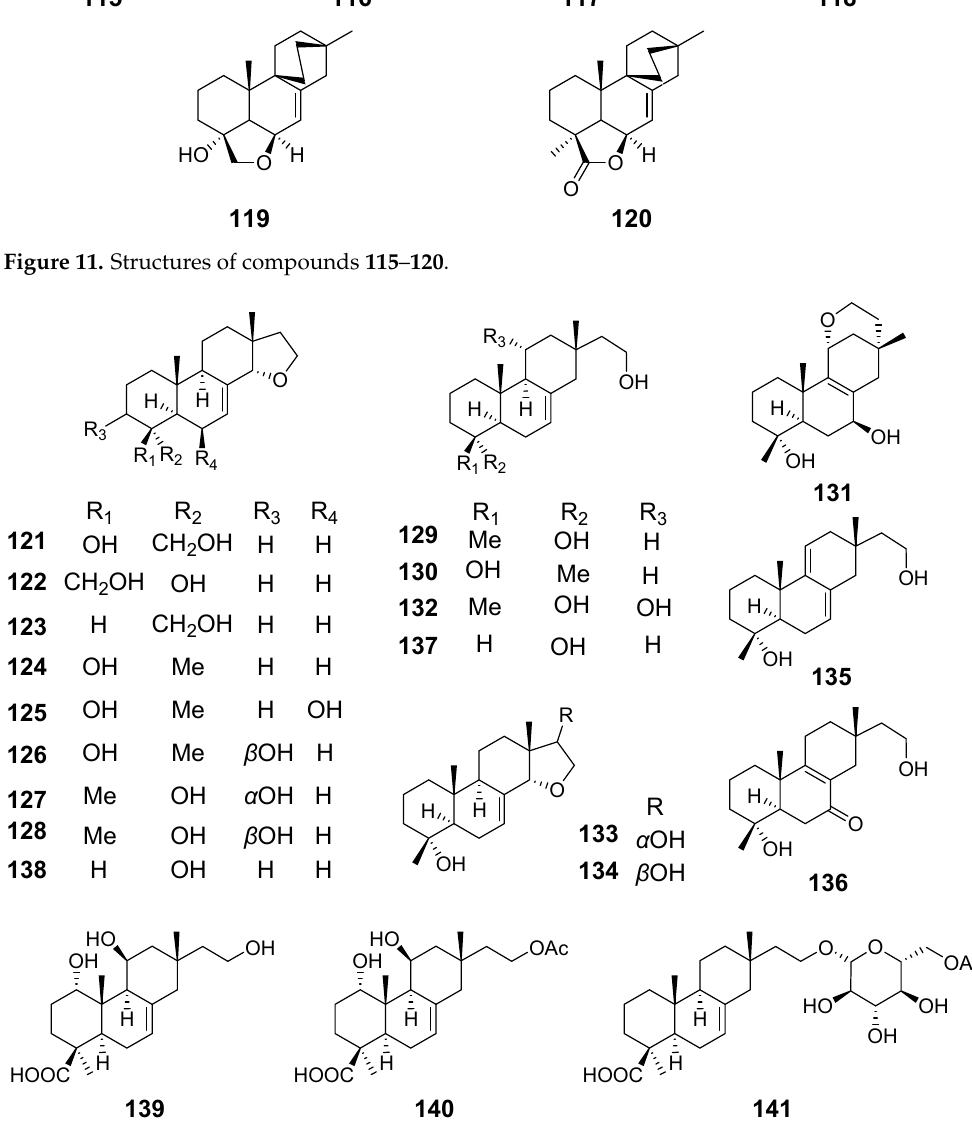
Figure 12. Structures of compounds 121 – 141 .